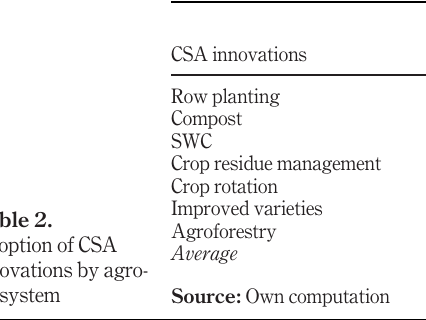
innovations by agro-